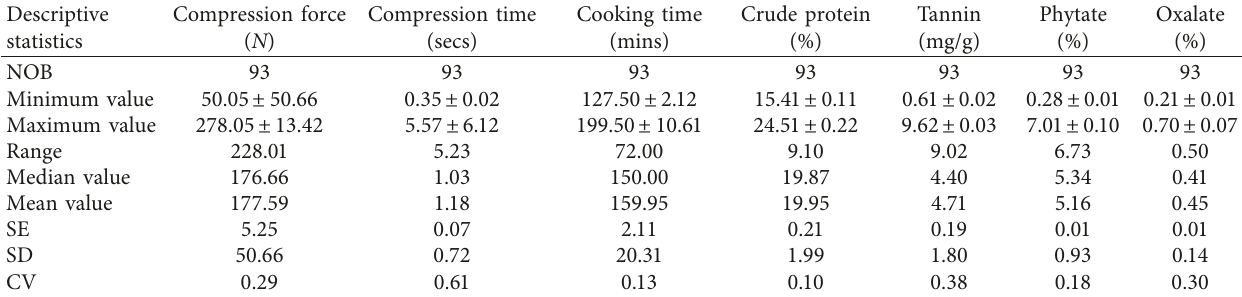
Table 1: Descriptive statistics of 93 AYB accessions for compression force, compression time, cooking time, crude protein, tannin, phytate, and